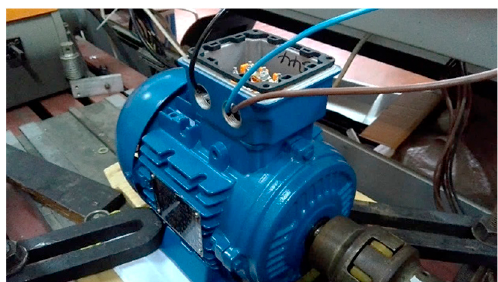
Figure 8. Squirrel-cage induction machine used as SEIG. Energies 2020 , 13 , x FOR PEER REVIEW Table 2. Nameplate data of the squirrel-cage induction machine used as SEIG.